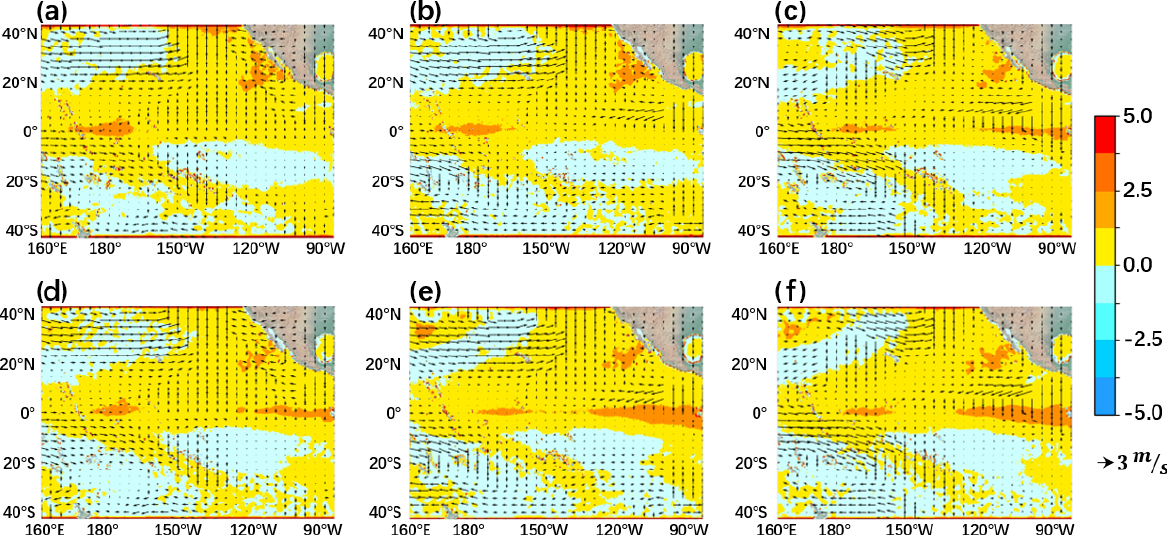
Figure 17. The growth phase of SST and wind anomalies in the 2015–2016 super Niño event from April 2015 to June 2015. Panels (a) – (c) show the forecast results of the ENSO-ASC and (d) – (f) show real-world